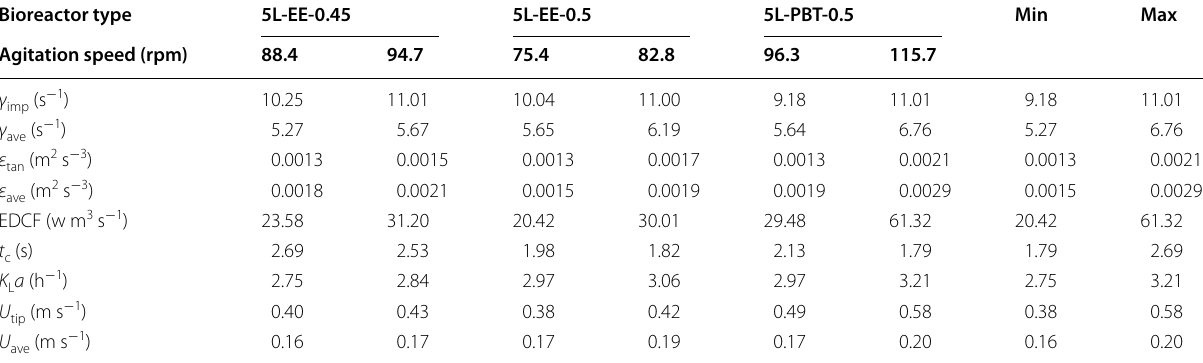
Table 3 Optimal hydrodynamic characteristic values of 5-L bioreactors at the optimized agitation speed ranges Bioreactor type